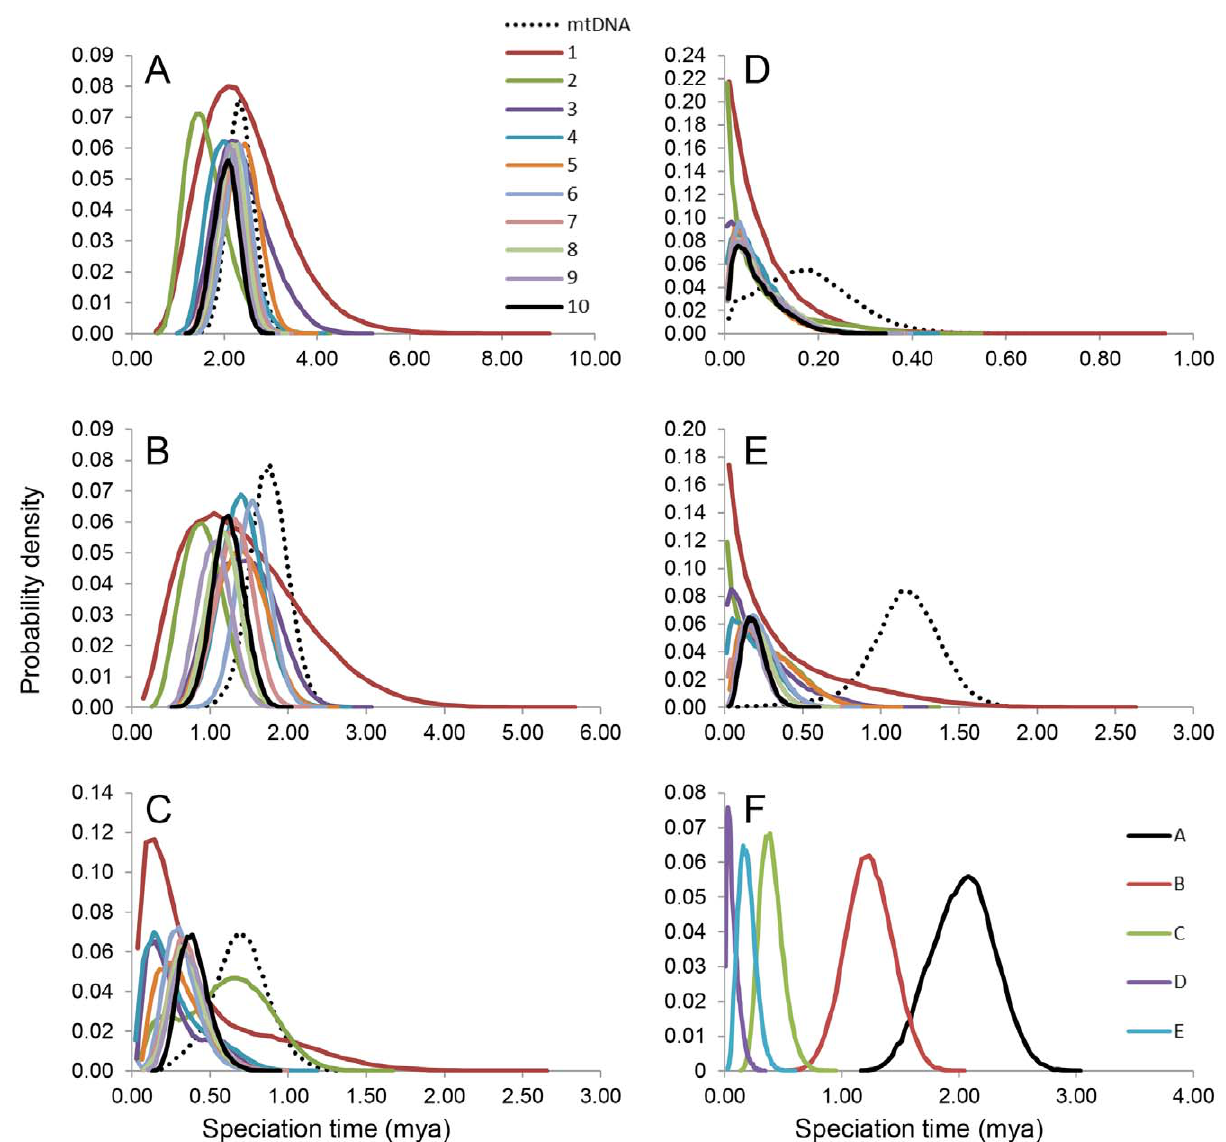
Figure 4. Density plots of posterior distributions of speciation times from MCMCcoal. Each graph represents a species tree node and the colors correspond to the number of loci used to estimate speciation time, million years ago (mya). A) carneus – all other lineages; B) igneus / mariae – cardinalis / coccineus / saturatus ; C) cardinalis – coccineus / saturatus ; D) saturatus – coccineus ; E) mariae – igneus ; F) speciation time estimates for each node. Nodes D and E refer to the island-mainland